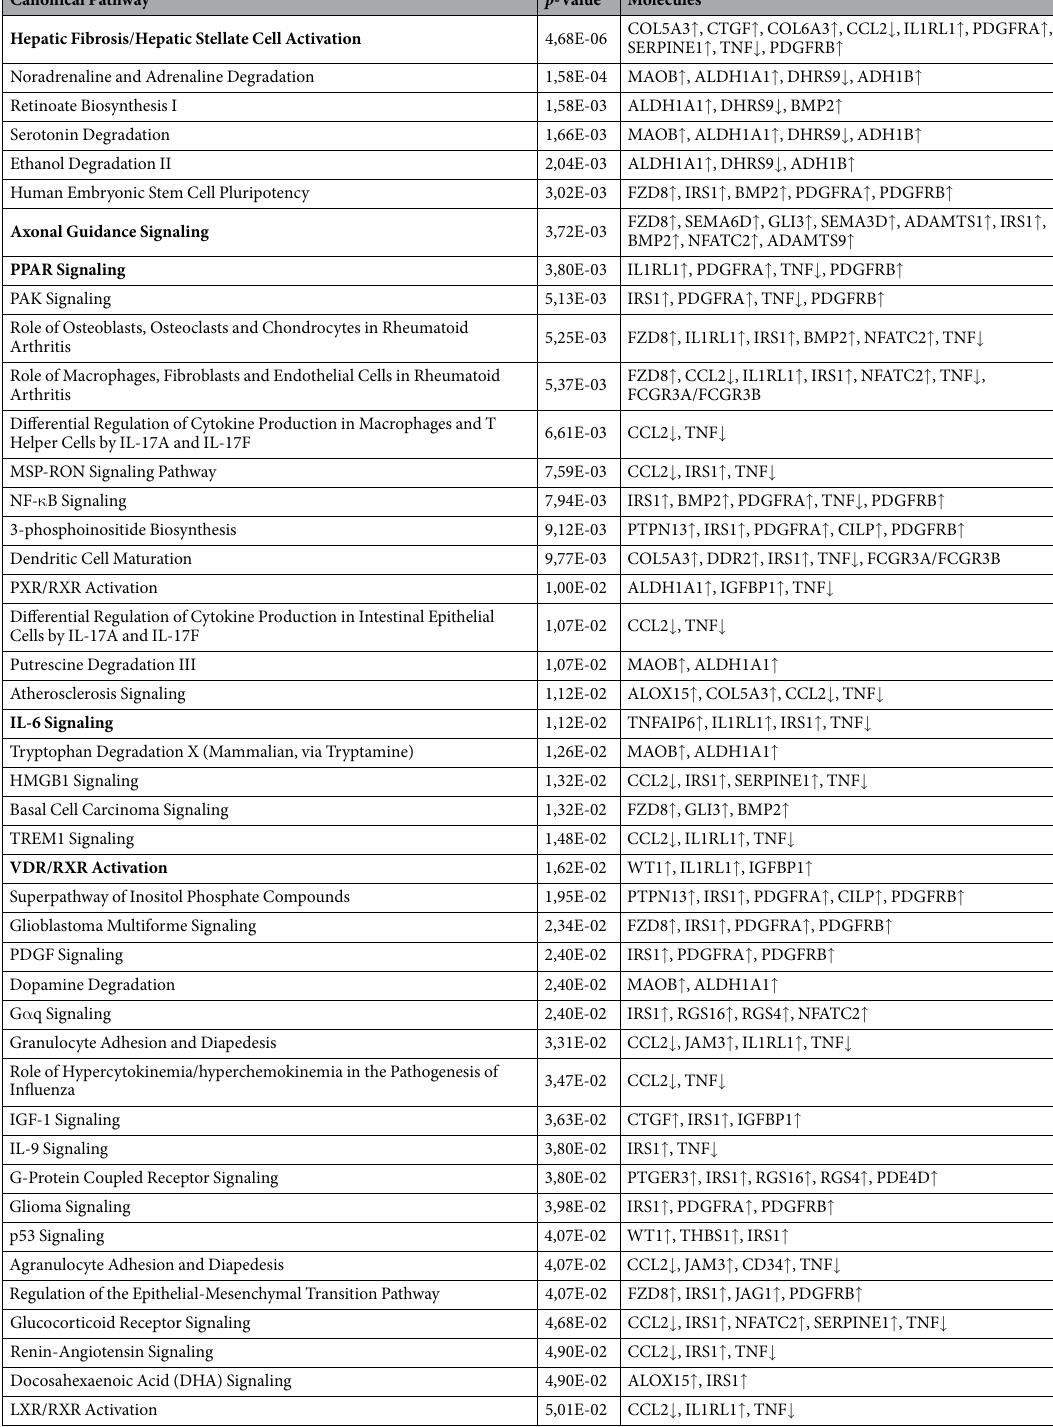
Table 3. Pathways enriched in the transcriptome of peritoneal effluent cells obtained from PET tests in the randomized trial with and without AlaGln. Analysis of PD effluent cells of the 4 h PET time point. a Comparison control without AlaGln versus 8 mM AlaGln in PDF. ↑ up regulated molecules, ↓ down regulated molecules